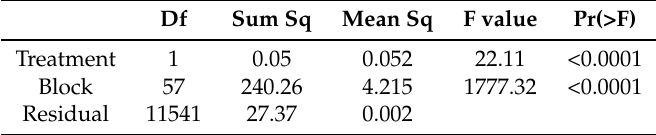
Table 4. Result of the analysis using randomized complete block design.